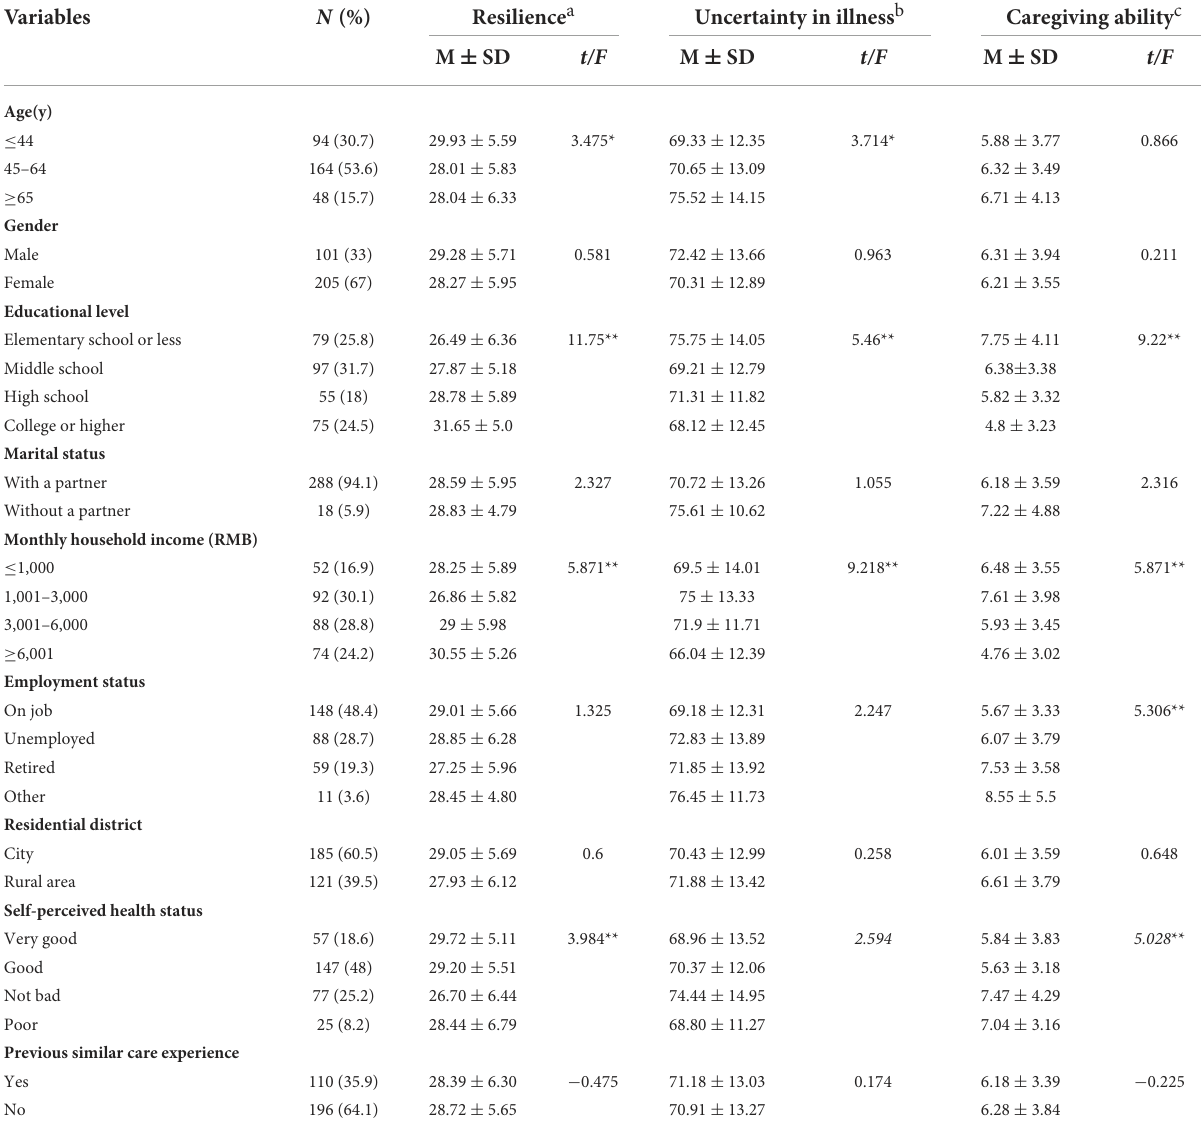
TABLE 1 Univariate analysis of sociodemographic characteristics of caregivers and the measured variables ( n = 306).